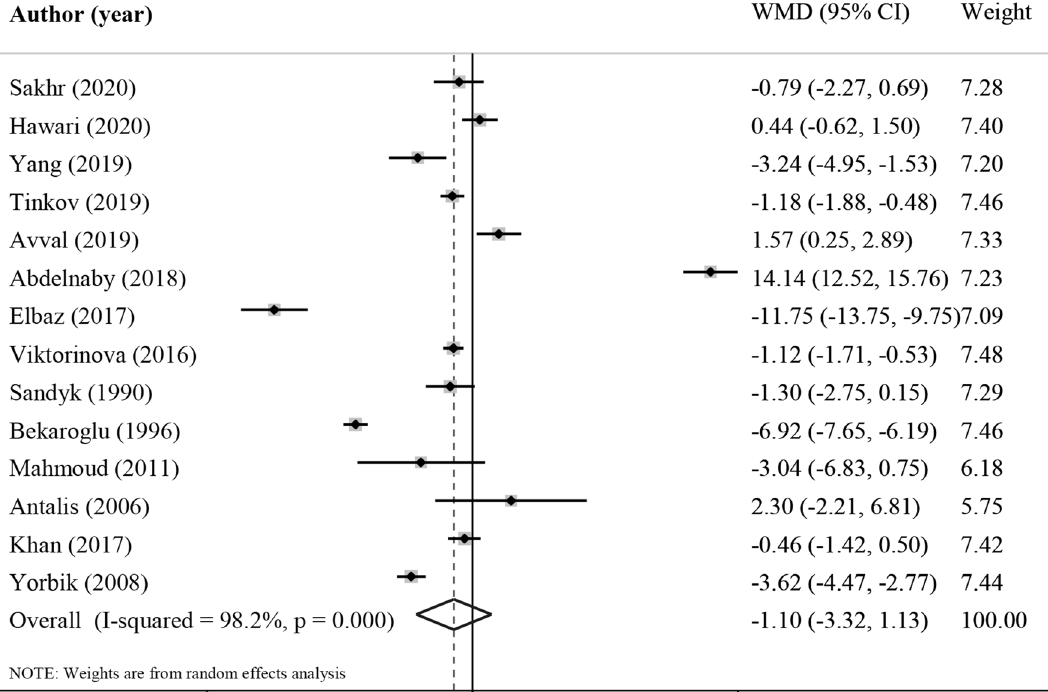
Figure 2. Forest plot for the association between serum zinc level and ADHD expressed as mean difference between case and control groups. The area of each square is proportional to the inverse of the variance of the WMD. Horizontal lines represent 95%Cis. Diamonds represent pooled estimates from random-effects analysis. WMD, weighted mean